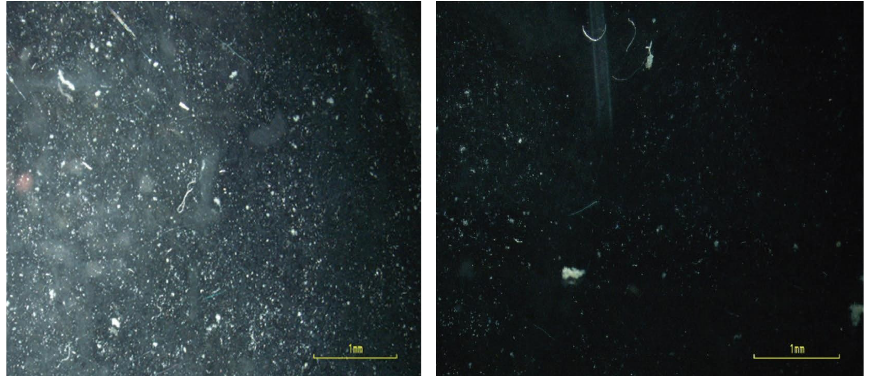
Figure 4: Observation of microplastic particles (respectively) in the sample of incoming wastewater and the efuent sample taken out of the treatment plant before the separation process.